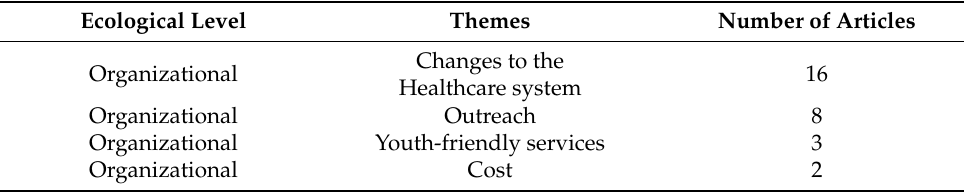
Table 3. Facilitators to Access to Care for